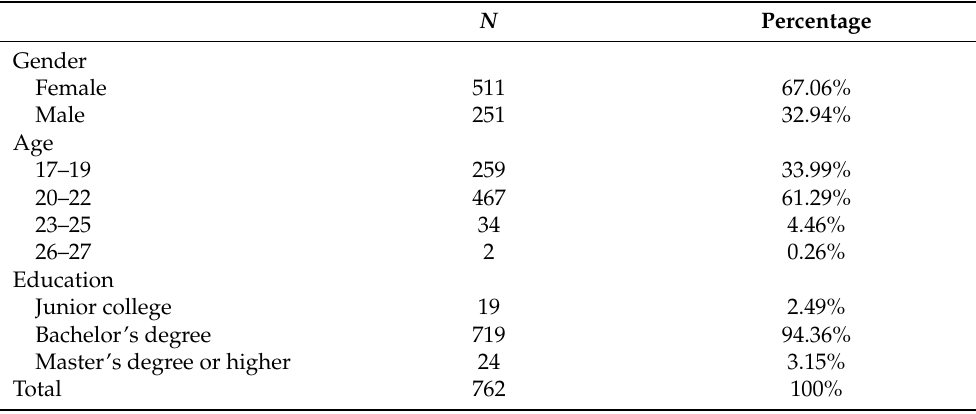
Table 1. Demographics of Participants ( N =